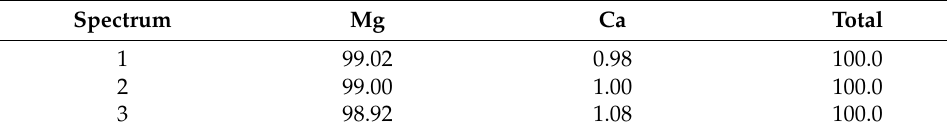
Table 1. SEM-EDS results for the prepared Mg-Ca alloy